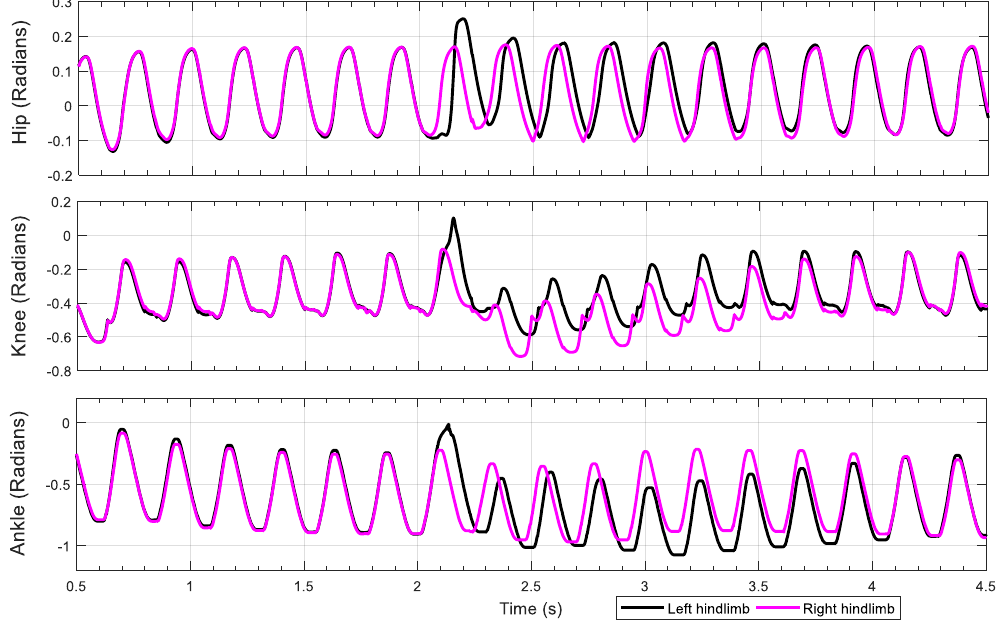
Figure 8. Limb joint motion during a non-resetting experiment. The stimulus is applied to the left hip pattern formation extensor neuron from 2 to 2.1 s with a current of − 10 nA.